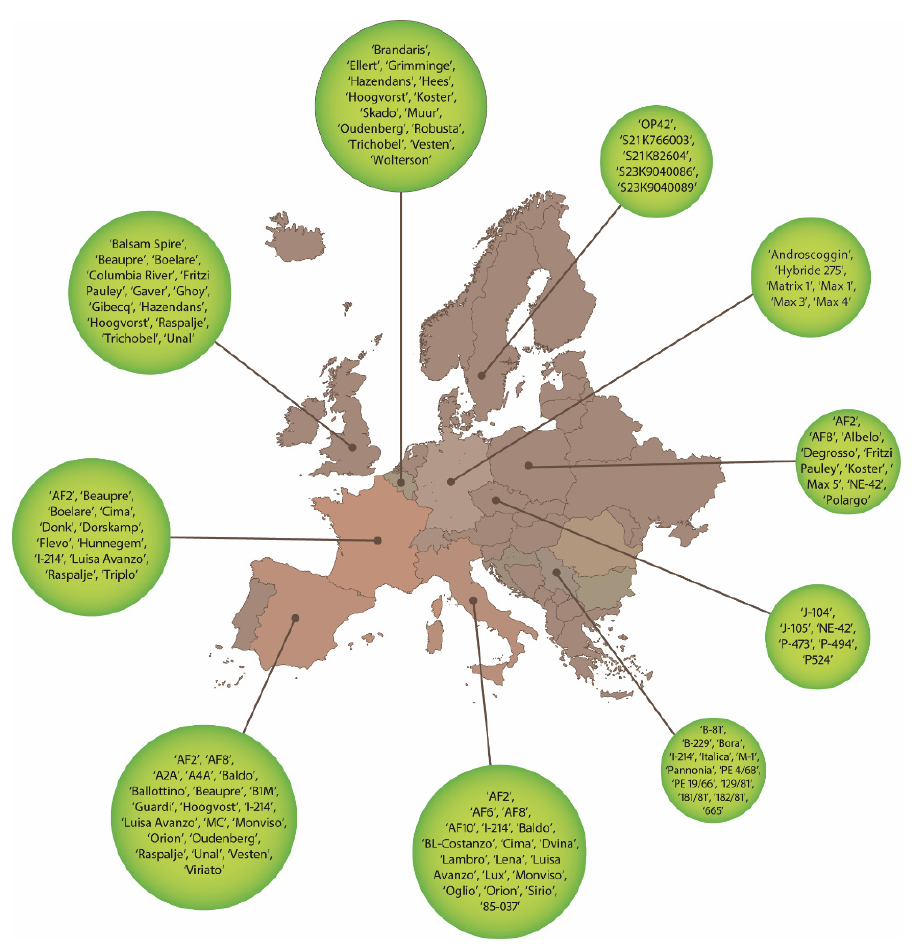
Figure 1. Some of the main genotypes planted for biomass purposes in each country are represented on a European map.